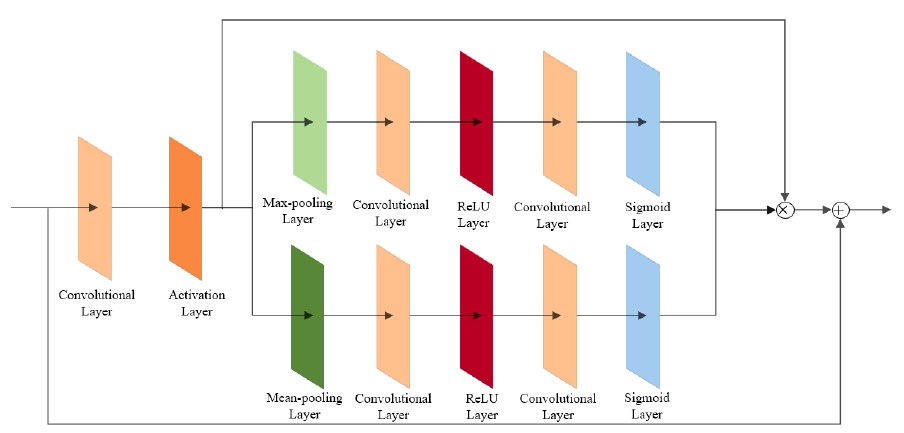
Figure 11. Structure of the attention module.